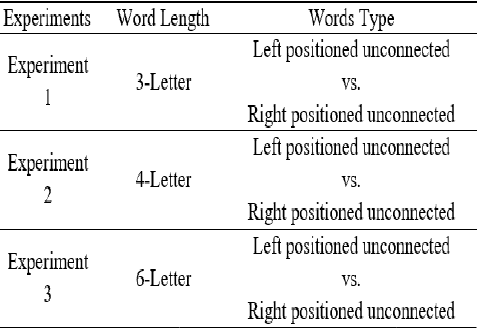
Table 3. Outline of the study